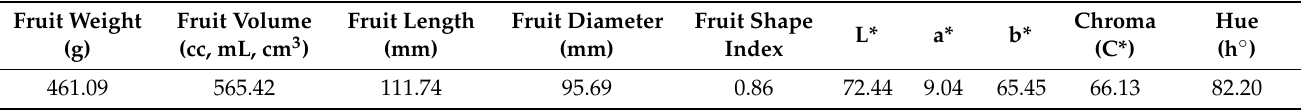
Table 1. Quince Physical and Color Properties Used in Drying